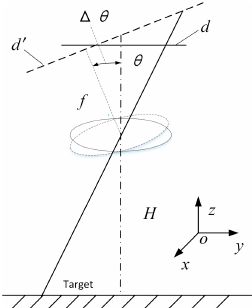
Figure 4. Pixel movement caused by translation.